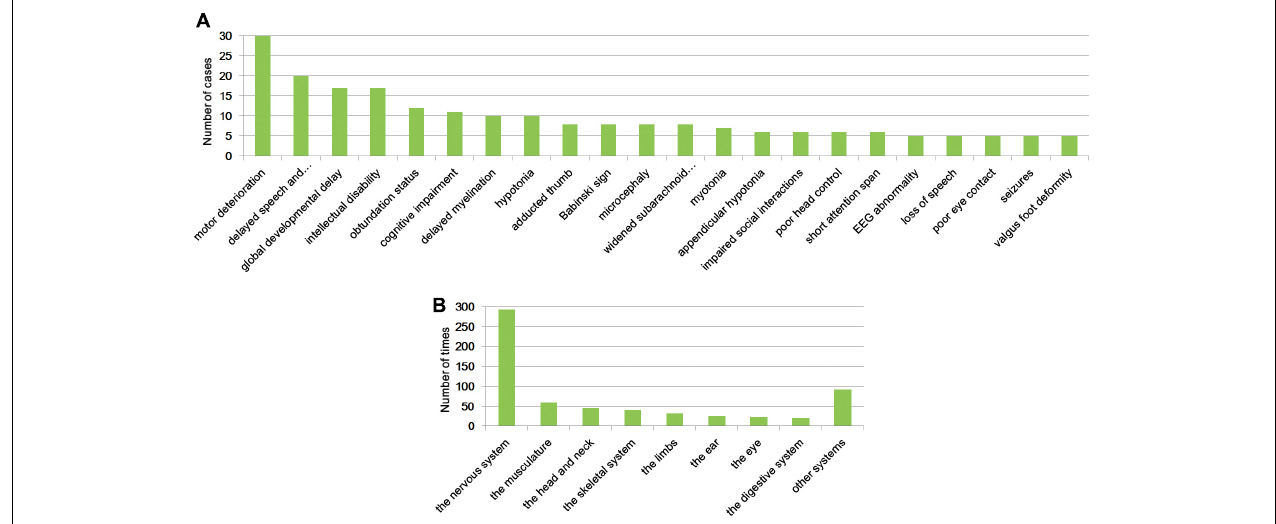
FIGURE 1 | Clinical symptoms analysis. Clinical abnormalities found in more than five patients of the cohort (A) and the top eight systems that were affected (B) .